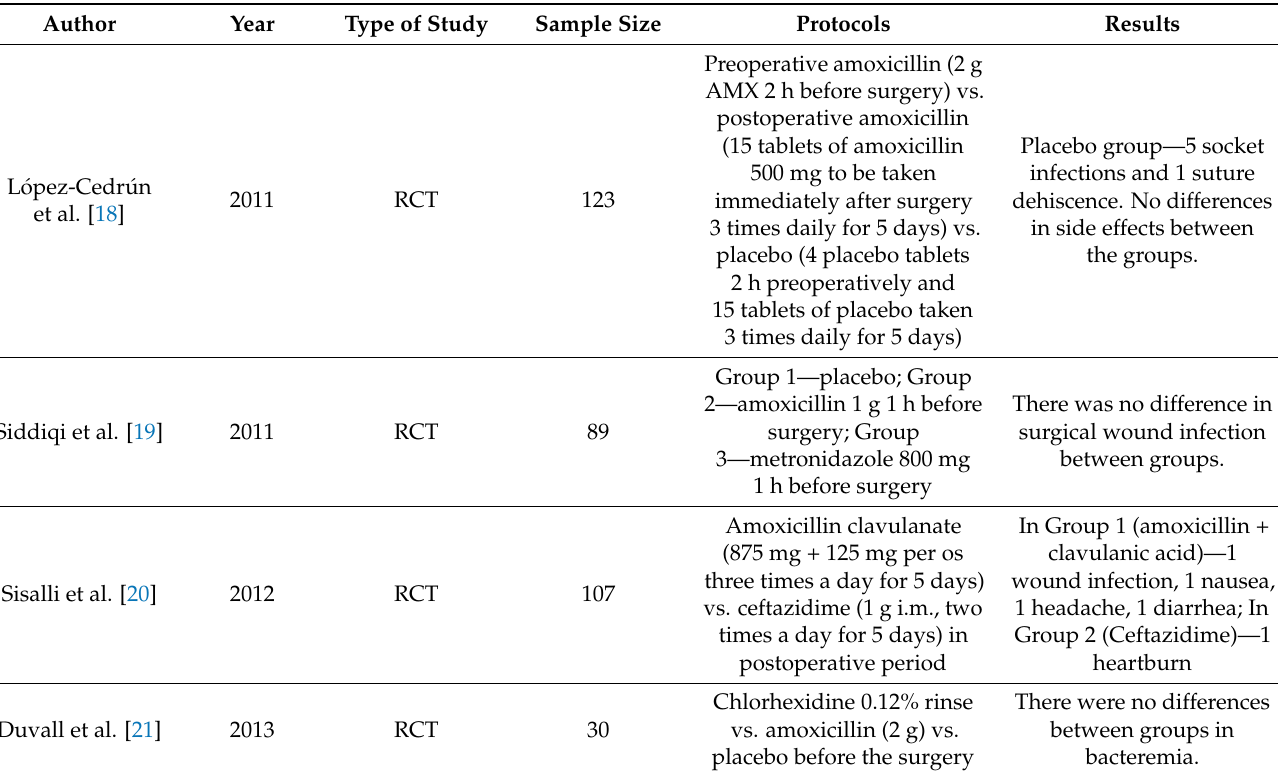
Table 1. Characteristics of included studies—randomized controlled